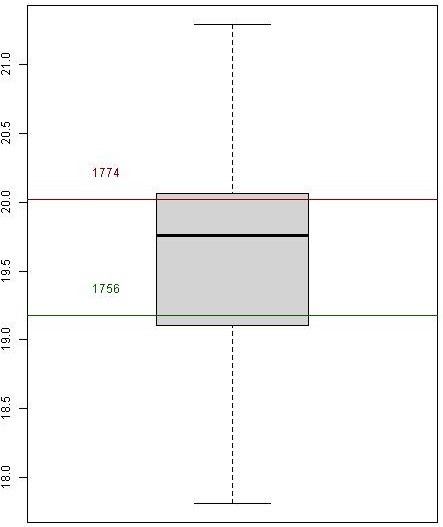
Boxplot for the mean of the temperatures from July to October. The box plot gives a representation of the concentration of the mean temperature (from July to October) over the period 1745 to 1850. The years 1774 and 1756 are pointed out. The middle 50% of the years fall inside the grey box, whereas the 25% warmest and 25% coldest years are above and below the box, respectively. The black line in the rectangle corresponds to the median temperature.